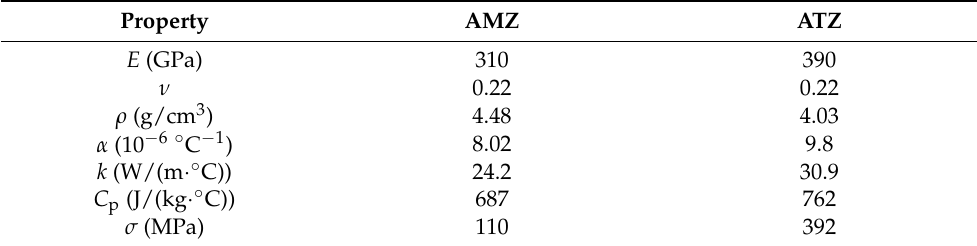
Figure 3. Geometric model diagram of four-point bending test for layered ceramics. Table 1. Material parameters of Al 2 O 3 /ZrO 2 -layered ceramics [8].